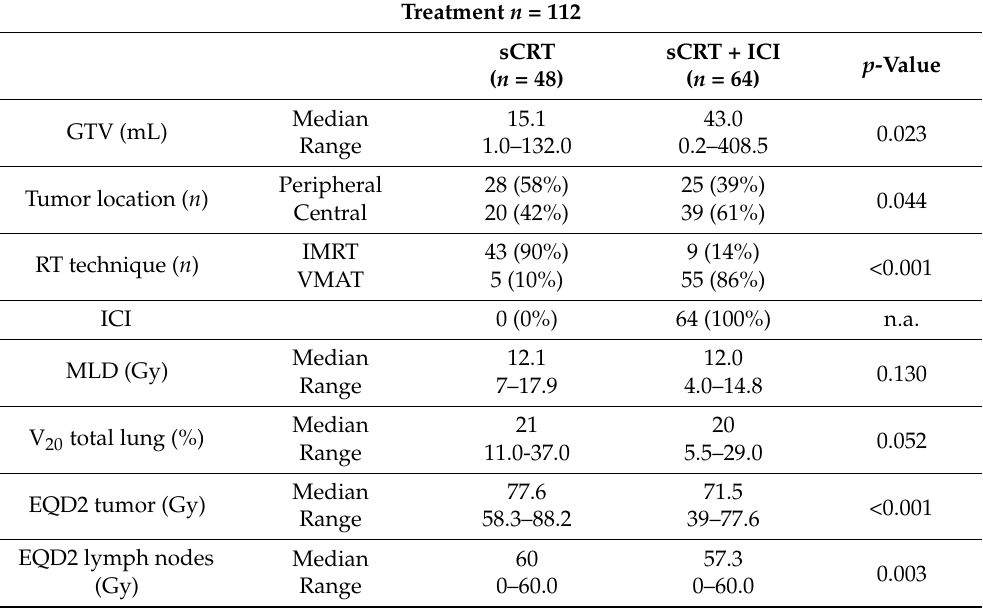
Table A2. Patients stratified by immunotherapy (sCRT = sequential chemoradiotherapy, GTV = gross tumor volume, RT = radiotherapy, ICI = immune checkpoint inhibitor, MLD = mean lung dose,